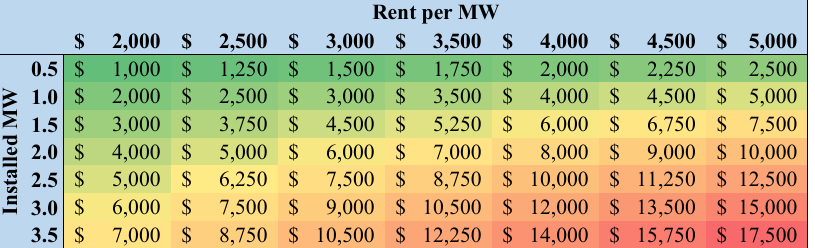
Figure 3. Counties in the US classified according to the Rural–Urban Continuum Codes as indicated by USDA.